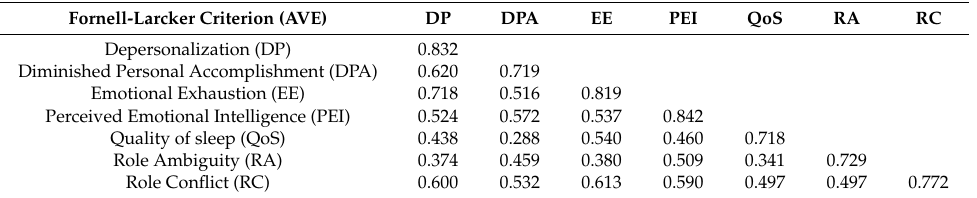
Table 3. Internal validity: Fornell–Larcker.